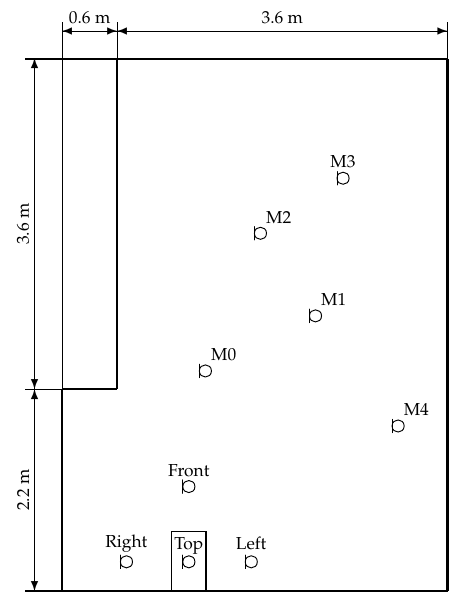
Figure 5. Laboratory setup.